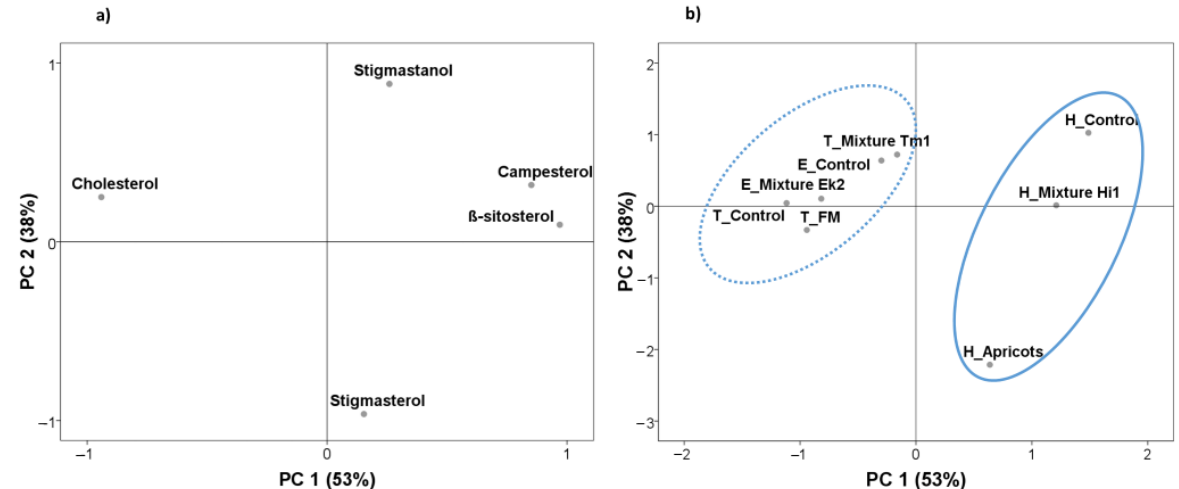
Figure 2. Scattering the data of sterols by the first two principal components (PC1 and PC2): analysis of different insect species fed different diets. ( a ) Biplot of the first two components created considering sterols; ( b ) rotated principal scores of insect species and their corresponding diets projected onto the first two principal components.